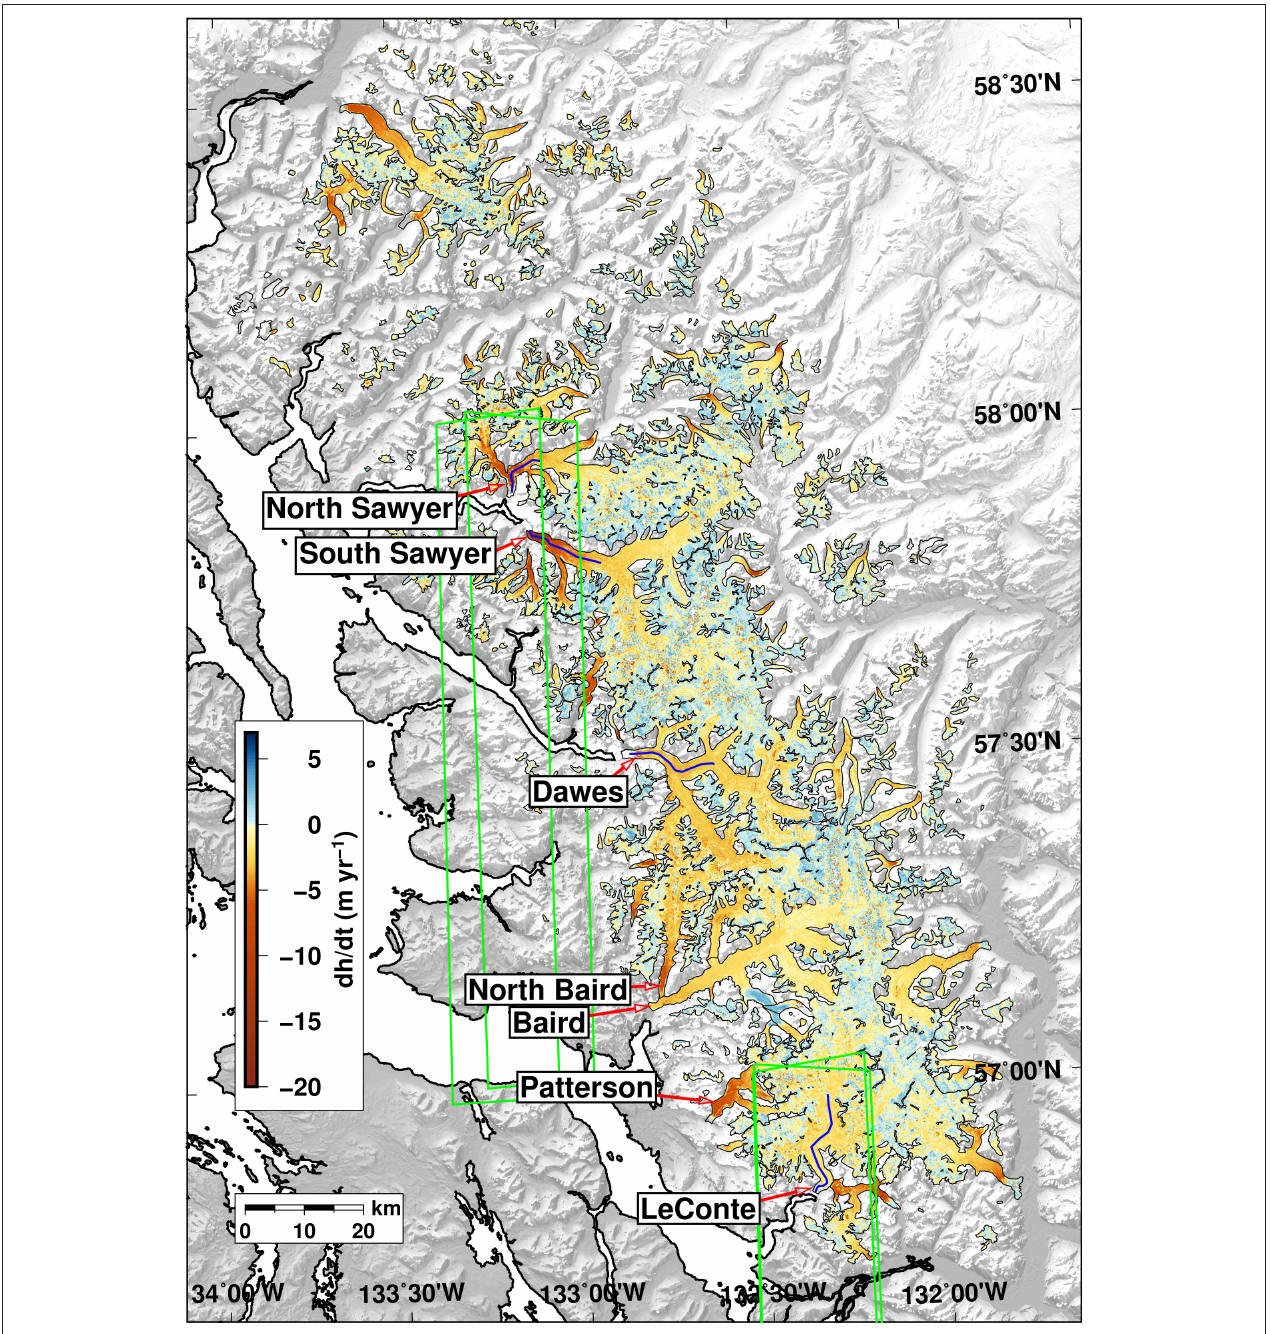
FIGURE 2 | Map of dh dt between 2000 and 2013/2014 for the Stikine Icefield from stacked ASTER DEMs and the SRTM DEM. The black lines indicate glacier boundaries (circa 2000). The purple lines at North Sawyer, South Sawyer, Dawes and LeConte glaciers indicate the locations of the centerline speed profiles shown in Figure 4 . The green lines indicate the coverage of the four WorldView DEMs used in this study.